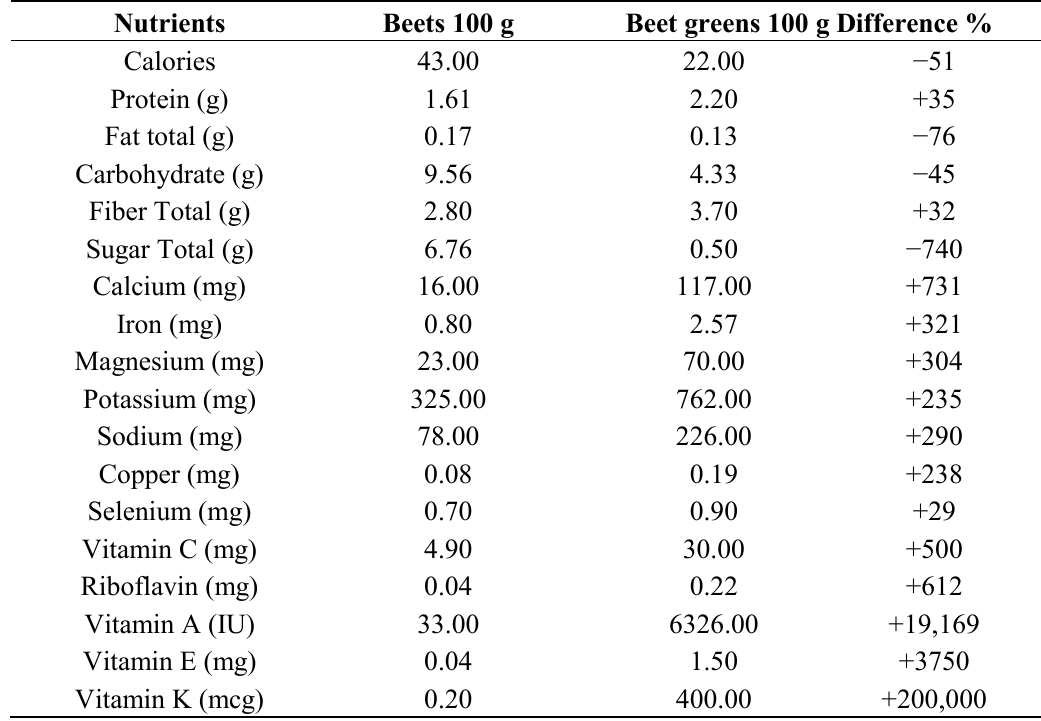
Table 13. Differences in ingredients between greens and roots of the same plant